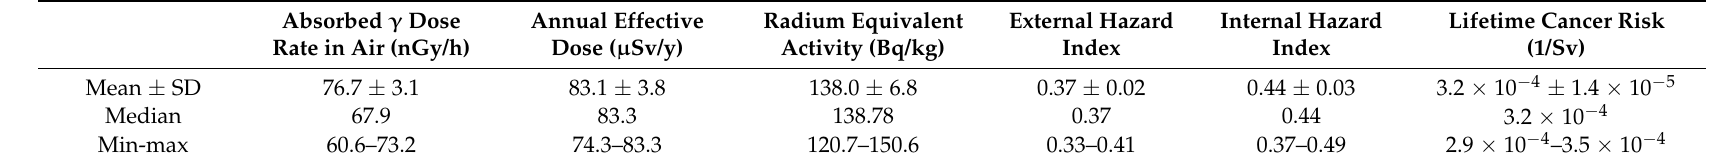
Table 3. The radiation hazard indices and lifetime cancer